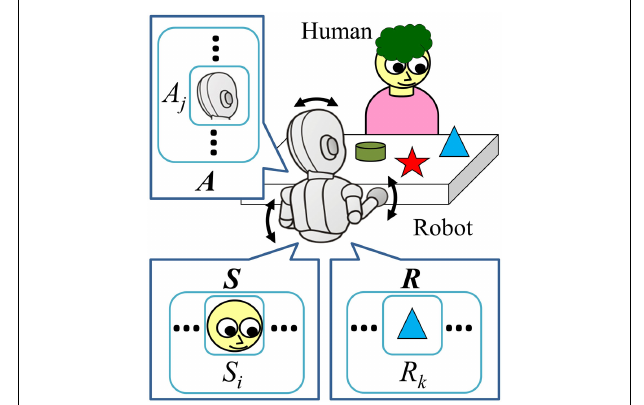
FIGURE 1 | Interactive environment: a human caregiver interacting with a robot across a table .